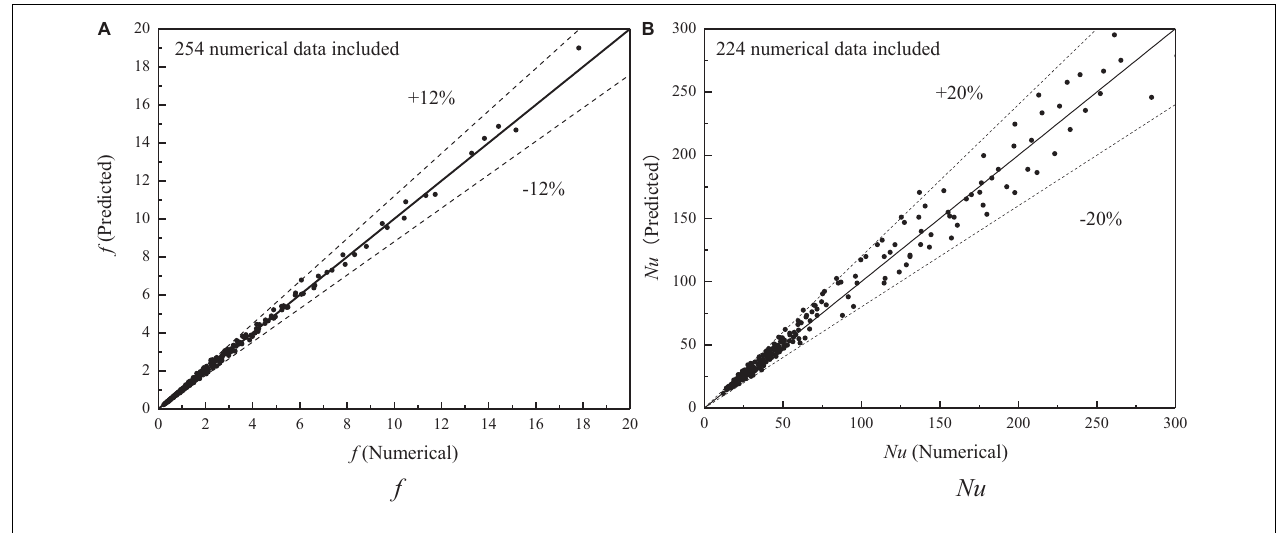
FIGURE 14 | Comparison of numerical results with predicted values of Nusselt number and friction factor. (A) f. (B) Nu.